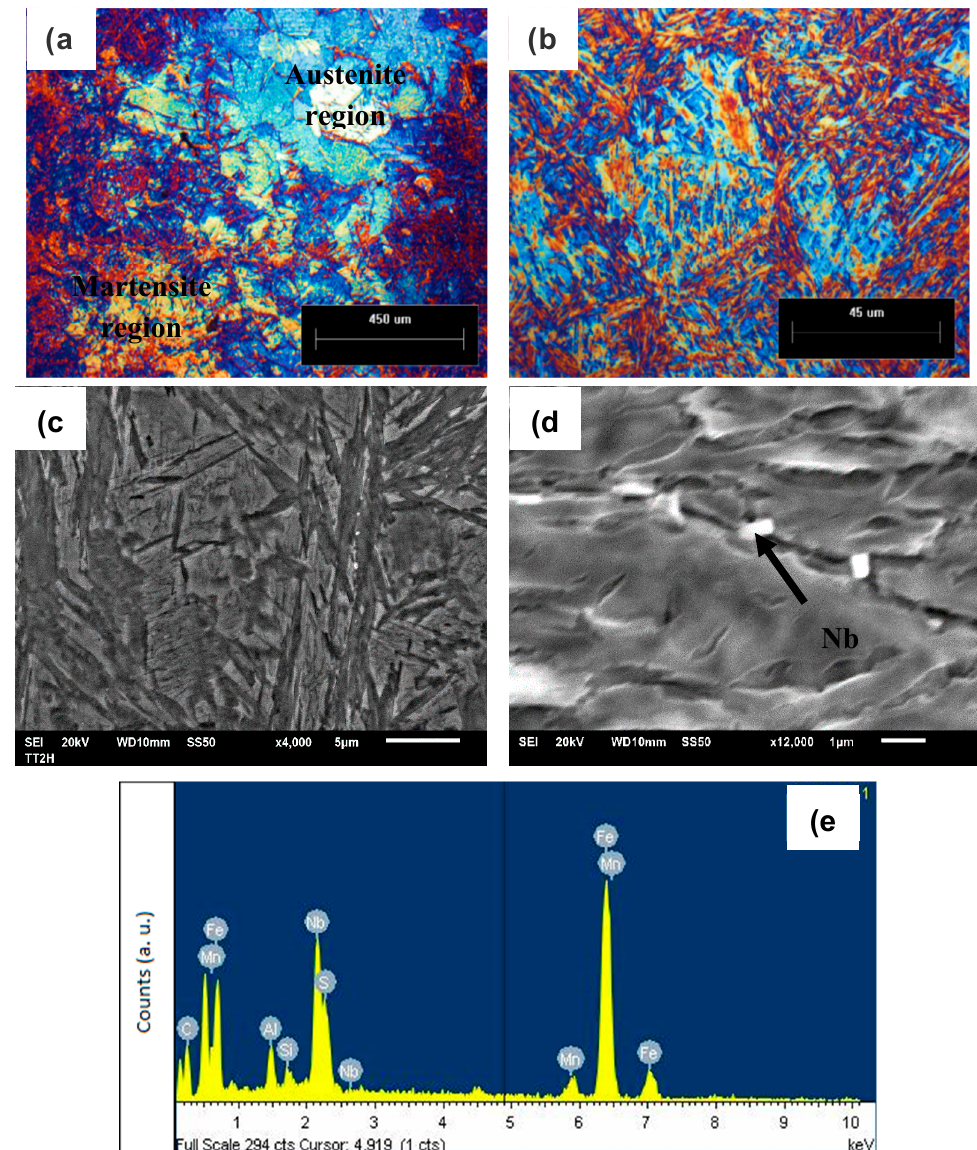
Figure 6. ( a , b ) Optical and ( c , d ) scanning electron microscope images showing the microstructure of the homogenized condition; ( e ) energy-dispersive X-ray (EDX) spectra of Nb carbides.